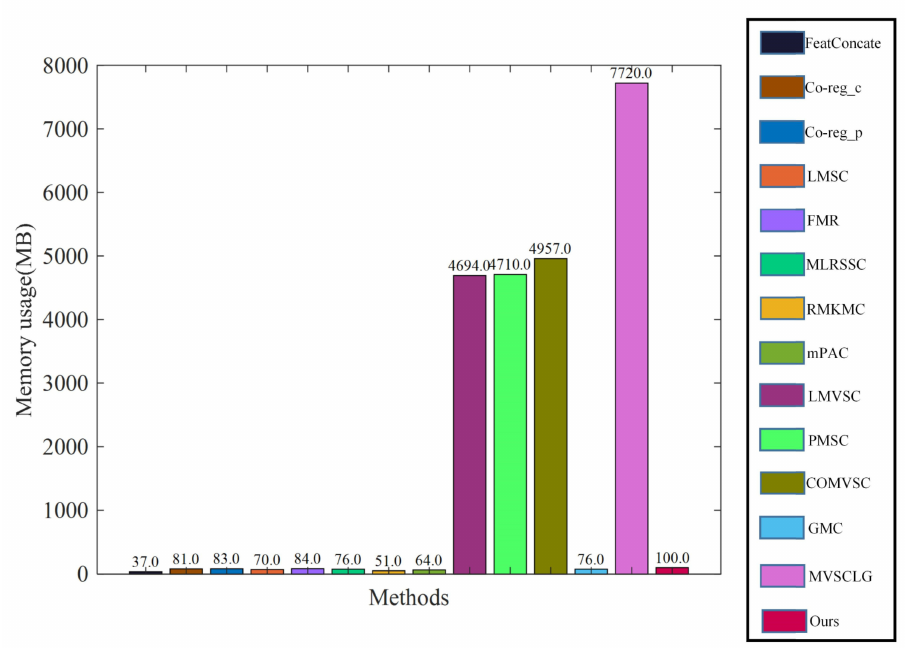
Figure 4. The memory usage representation of compared methods on